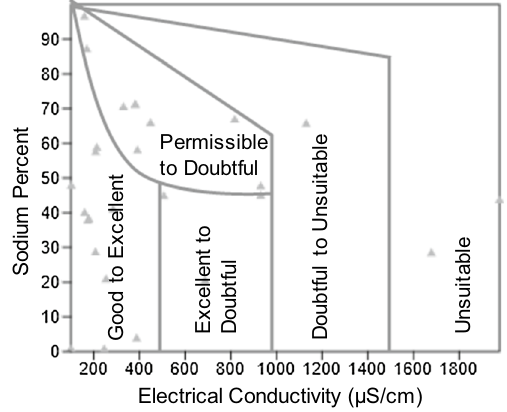
Fig. 16 Wilcox plot showing irrigation water classification in sub- Saharan